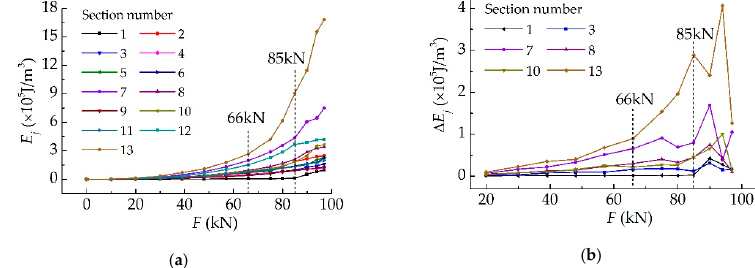
∆ E j - F curves; ( b ) j - F